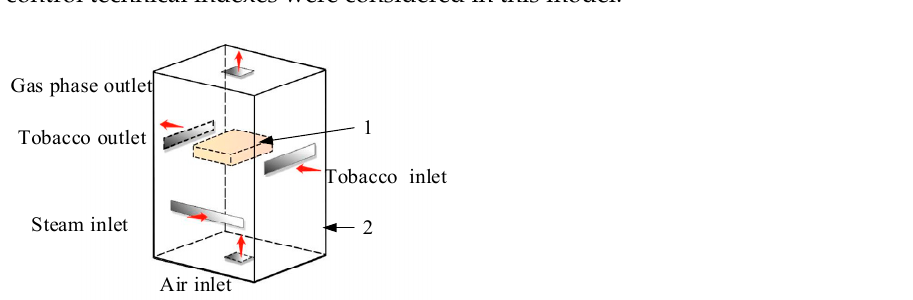
Figure 1. Schematic of heaped tobacco in rewetting session: 1—heaped tobacco strips; 2—rewetting box.